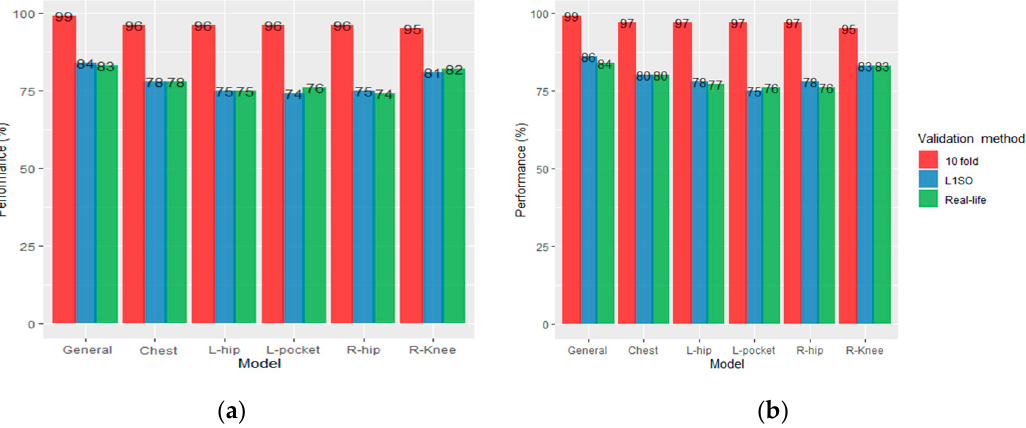
Figure 5. Overall accuracy of the RF classification models trained with combined dataset, ( a ) accelerometer data only and ( b ) accelerometer and GPS